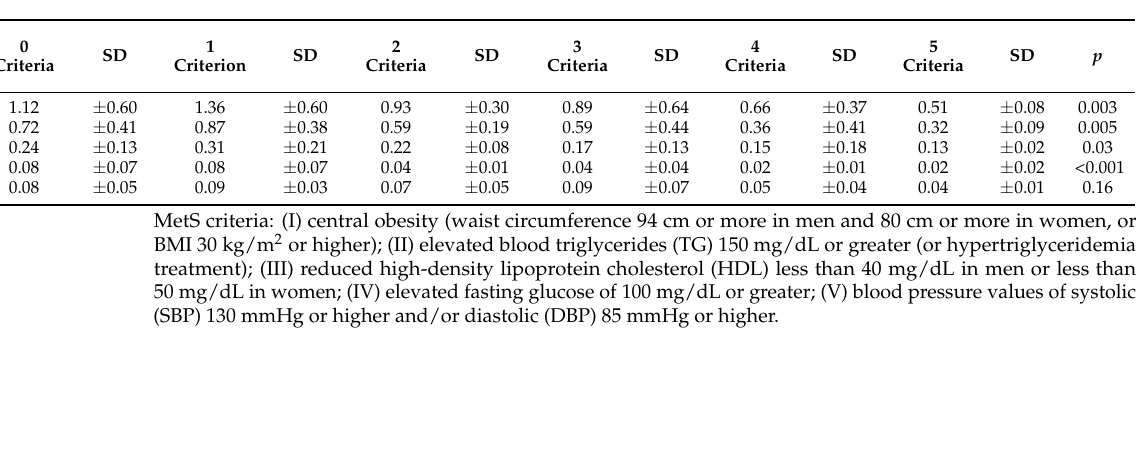
Figure 2. Box-plots presenting the differences in flavonols intake between subgroups with normal body mass, overweight and obese. Table 2. The comparison of flavonol intake between the subgroups meeting the consecutive numbers of metabolic syndrome (MetS)